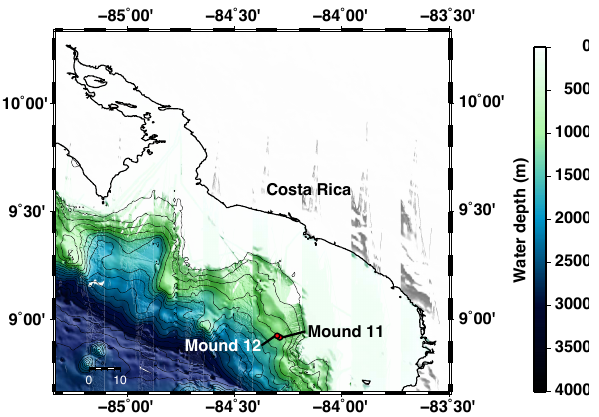
Fig. 1. Bathymetric map of the Pacific continental slope of Costa Rica; locations Mound 11 and Mound 12 are shown.